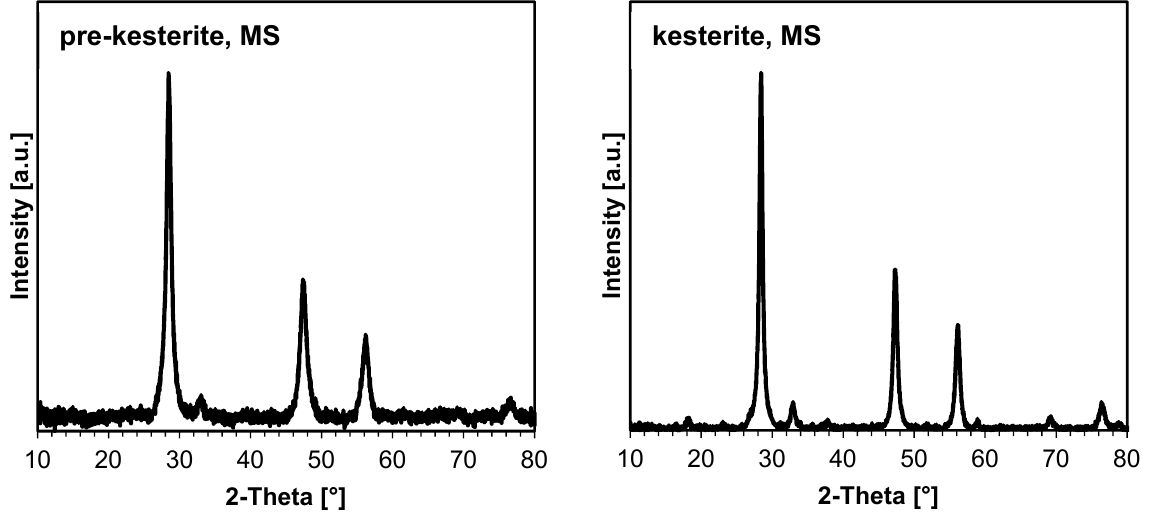
Figure 1. Typical nanopowder morphology, as examined by SEM for products in the CE sys- tem ( top row) and MS system ( bo tt om row).